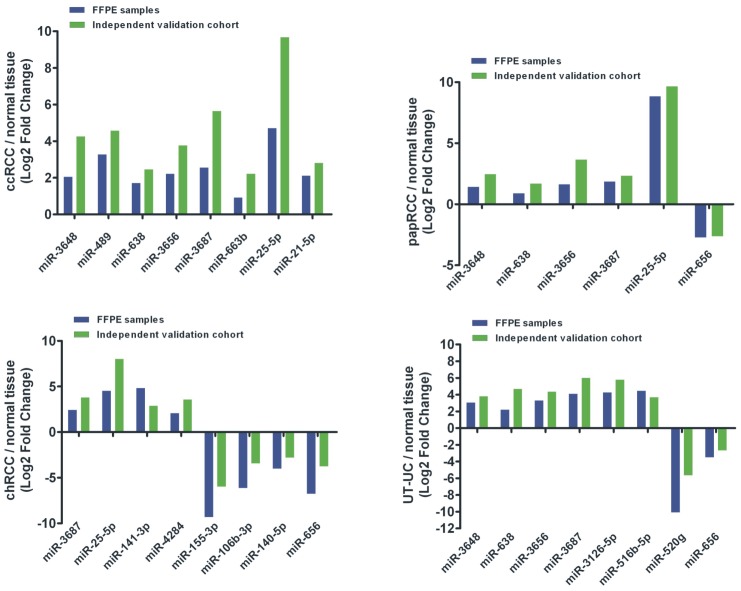
Validation in a blinded independent cohort.A blinded independent validation cohort composed of 40 freshly frozen ccRCC, papRCC, chRCC, UT-UC and normal kidney samples was also used to validate the discriminatory ability of the qRT-PCR verified deregulated miRNAs. The results were highly repeatable between the two cohorts, recapitulating the specificity of these miRNAs in each tumour group.